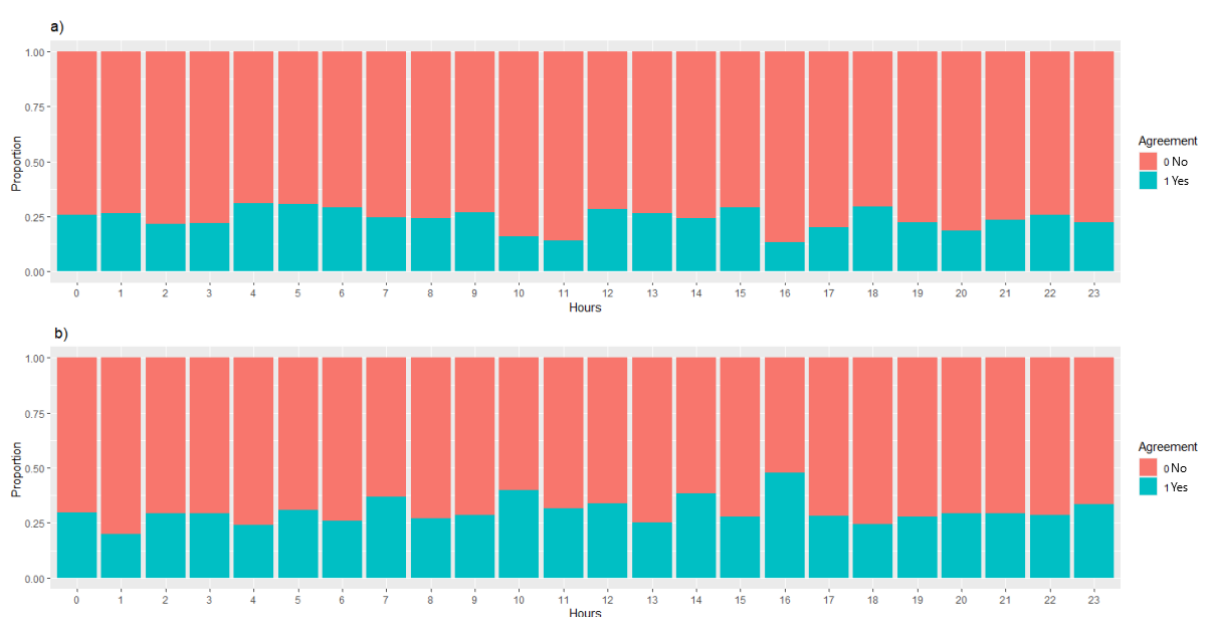
Figure 2. Activator nurse and computer agreement of (a) acute myocardial infarction and (b) not acute myocardial infarction. AMI: acute myocardial infarction; MI: myocardial